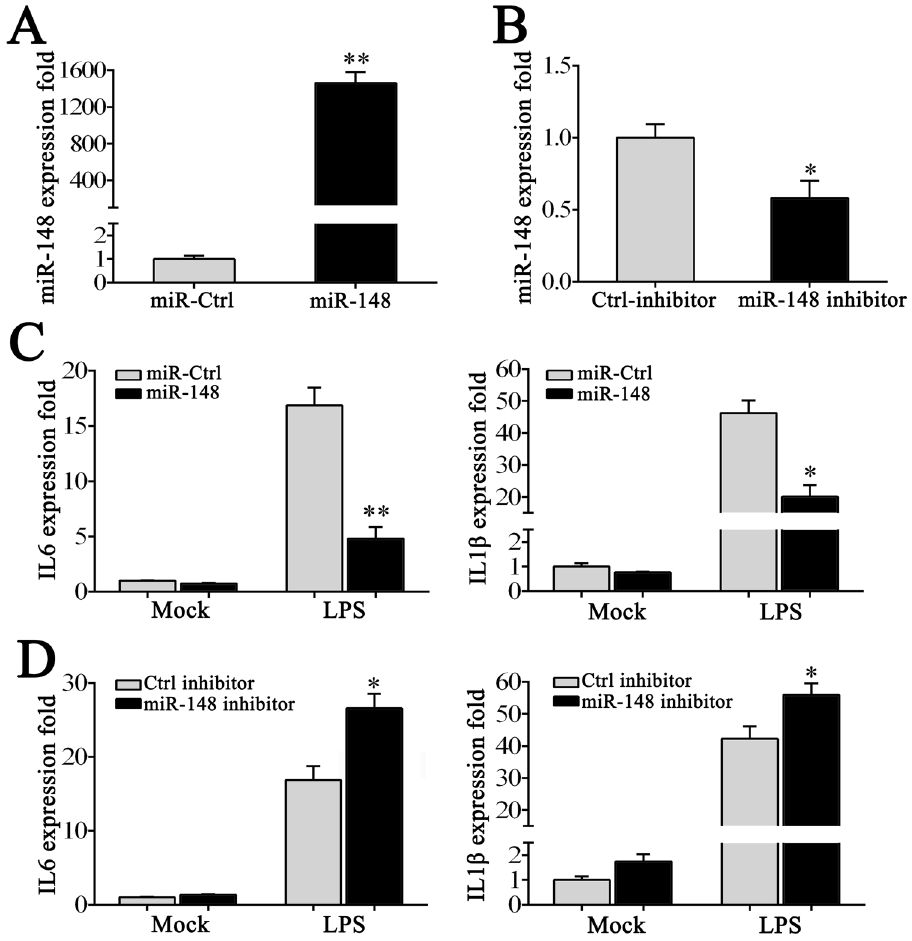
Figure 2. miR-148 suppresses the expression of IL-6 and IL-1 β in LPS-treated macrophages. Miiuy croaker macrophages were transfected with miR-Ctrl or miR-148 mimics ( A ) and Ctrl-inhibitor or miR-148 inhibitor ( B ) within a final concentration of 100 nM. After 24 h post-transfection, miR-148 expression was measured by qRT-PCR. The macrophages were transfected with miR-148 mimics or miR-Ctrl ( C ) and miR-148 inhibitor or Ctrl-inhibitor ( D ). After 24 h, the cells were stimulated with LPS for another 24 h, and the expression levels of IL-6 and IL-1 β were analyzed by qRT-PCR. Physiological water served as stimulation control. Data was presented as the means ± SE from three independent triplicated experiments. ** p < 0.01; * p < 0.05 versus the